Question: What type of chart is this?
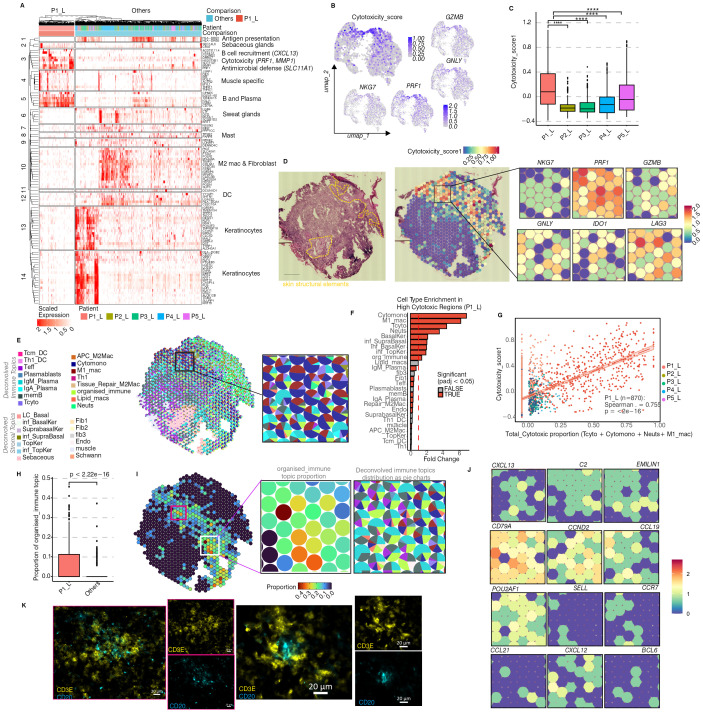
Answer: heatmap